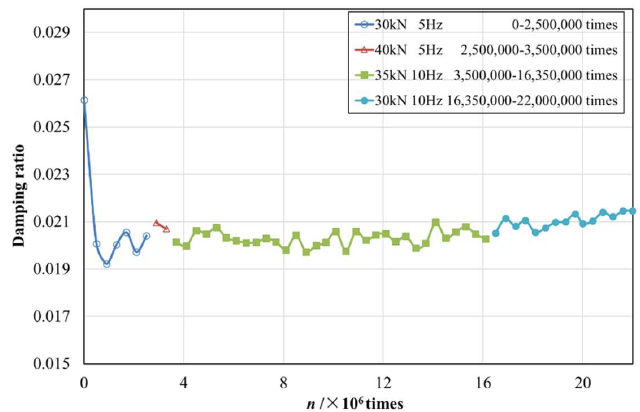
Figure 7. Damping ratio–cyclic number ( n ) curve of structural EPS concrete.